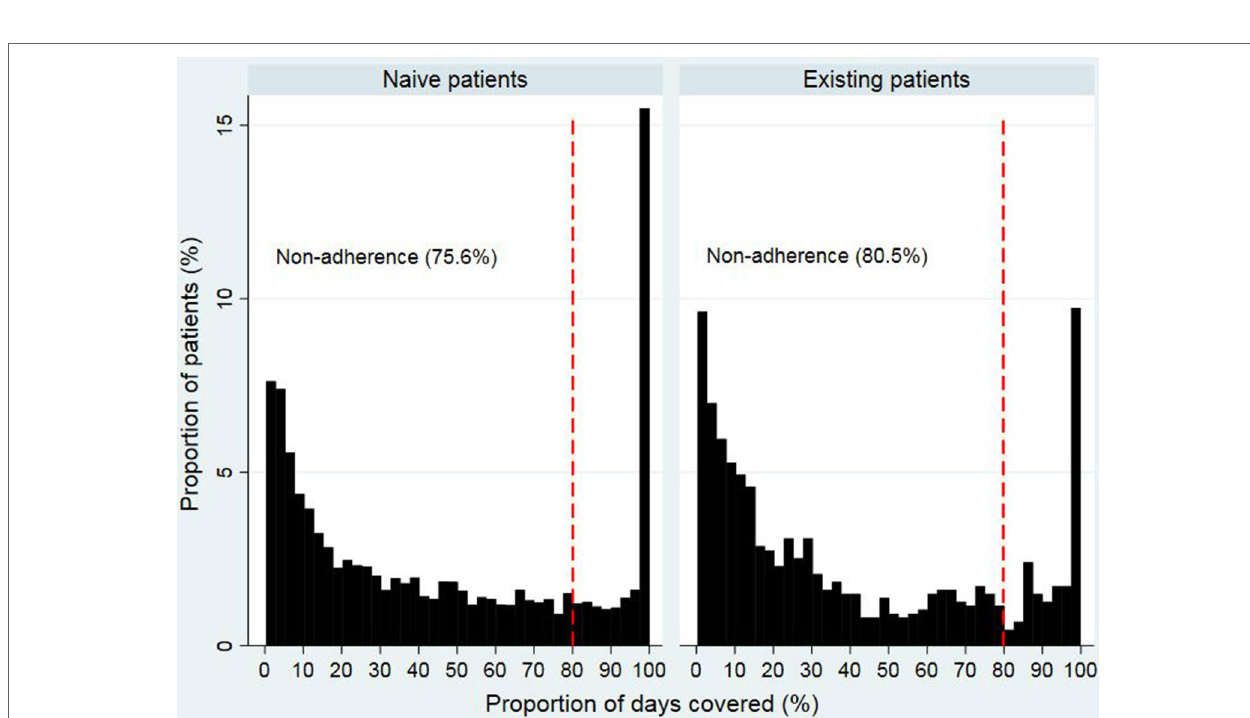
FiGUrE 2 | Proportion of days covered in opioid naïve and opioid existing patients.